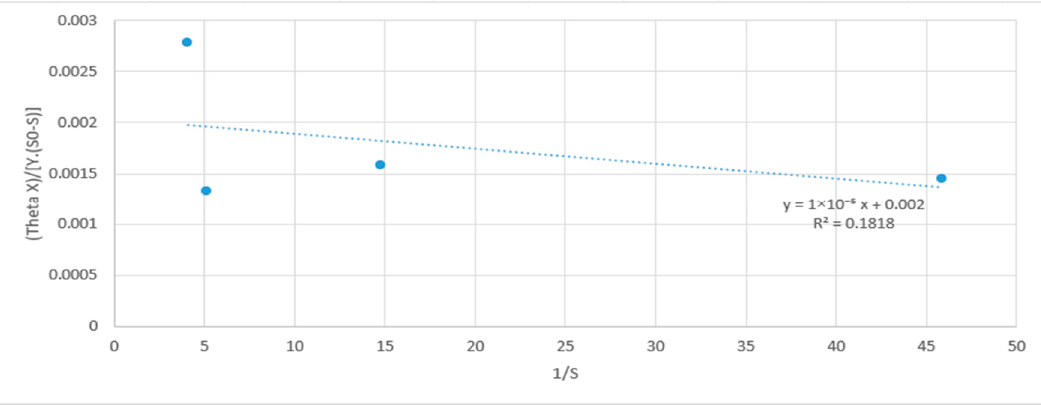
Figure 8. Graph of kinetic parameters ((µ and K s ) of the LTP’s activated sludge system.